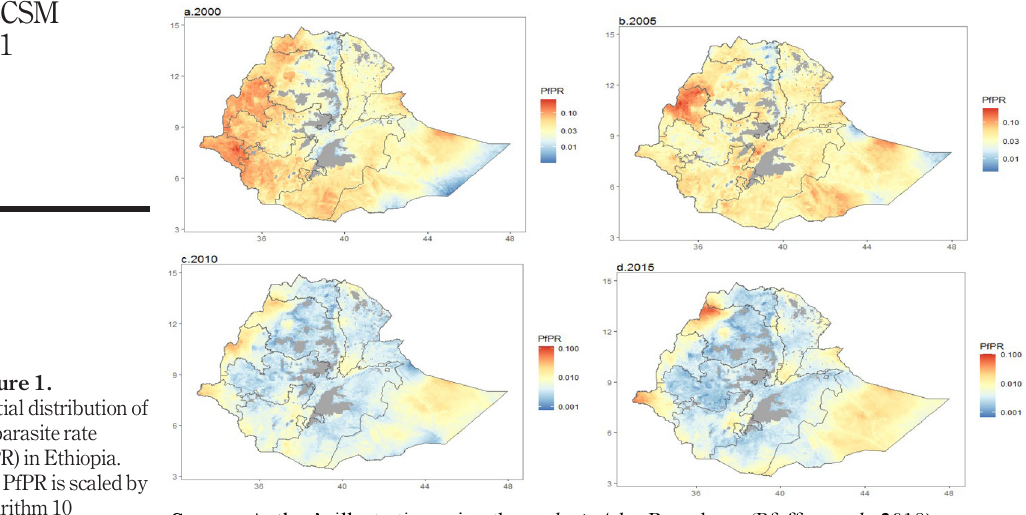
noticeable from July to September, and in the central and highland regions (World Bank, 2020; Gebrechorkos et al. , 2018).